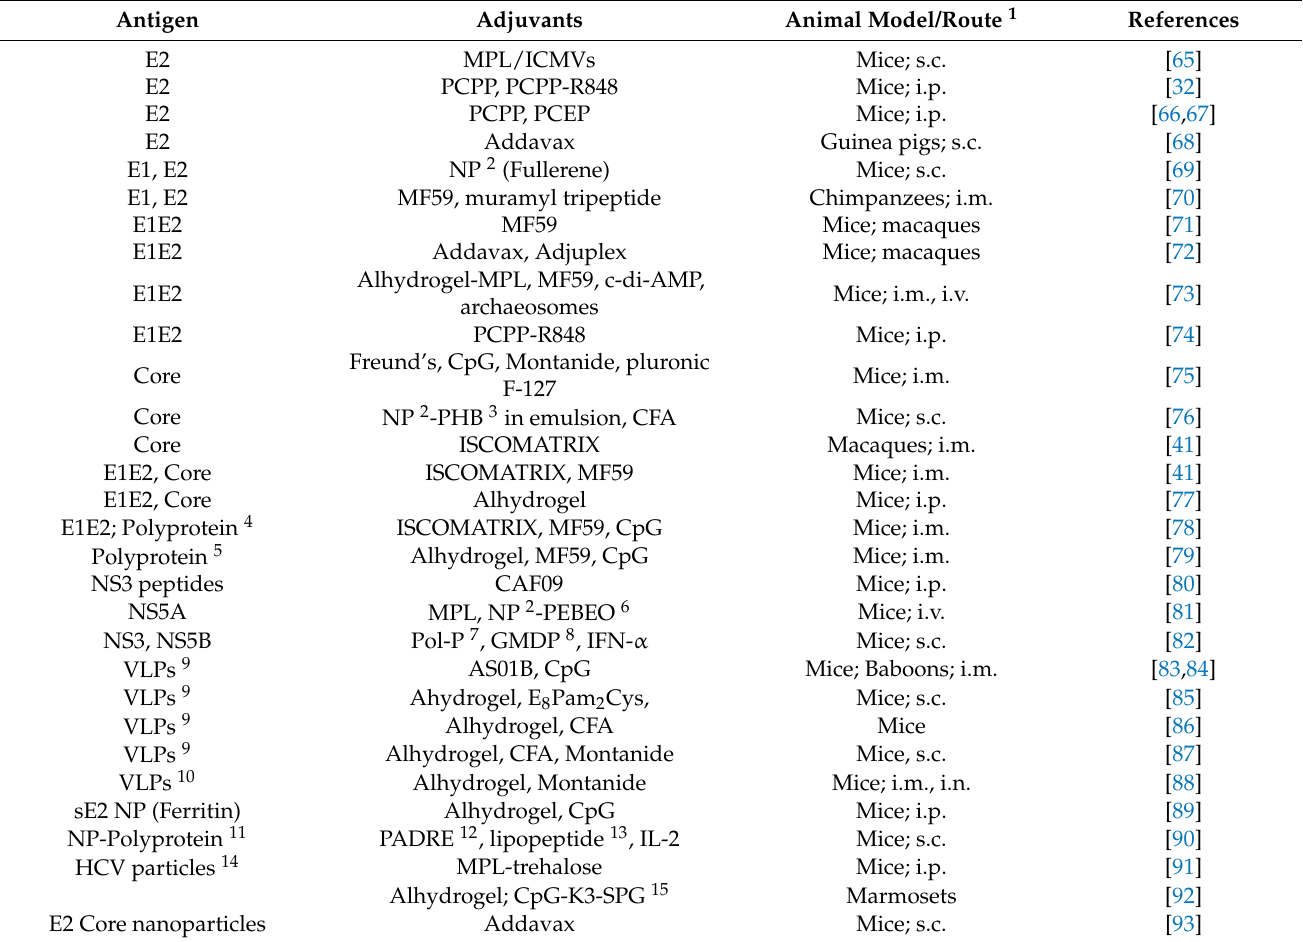
Table 1. Immunoadjuvants and vaccine delivery systems employed with protein-based HCV antigens. Antigen Adjuvants Animal Model/Route